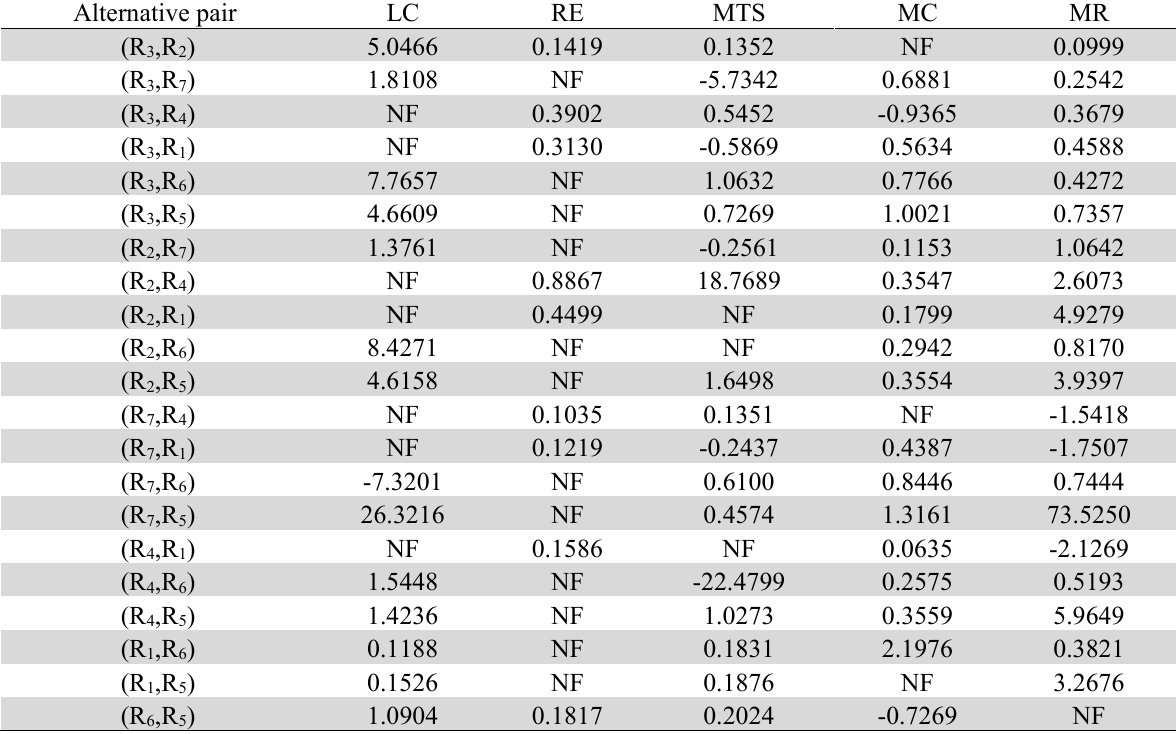
δ k,i,j values for robot selection Example 1 Alternative